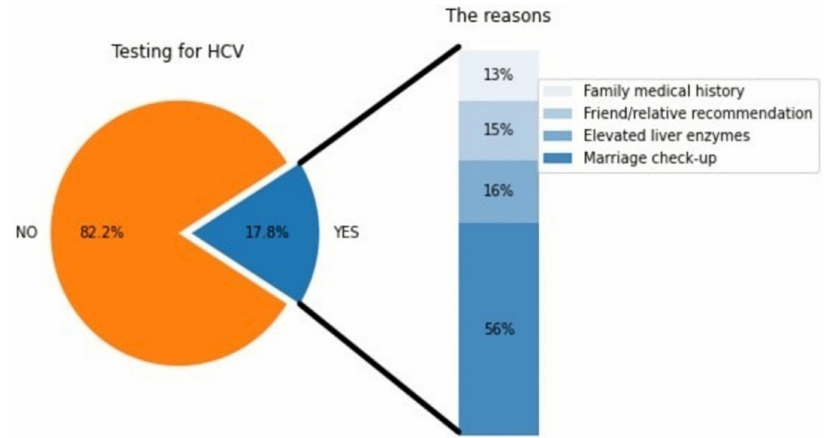
Figure 1. Self-reported HCV testing rate and the reasons for being tested.